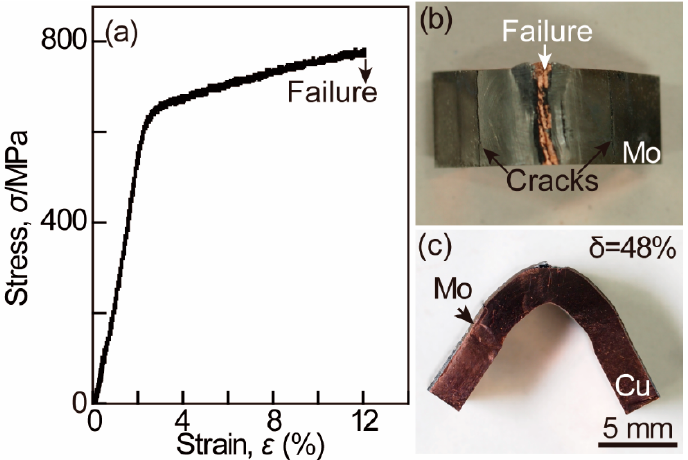
Figure 4. ( a ) A bending stress–strain curve at the cross-head speed of 0.5 mm/m at room temperature. ( b ) Top-view and ( c ) cross-sectional optical microscope (OM) images of a Mo/Cu LCV specimen after a bending test.